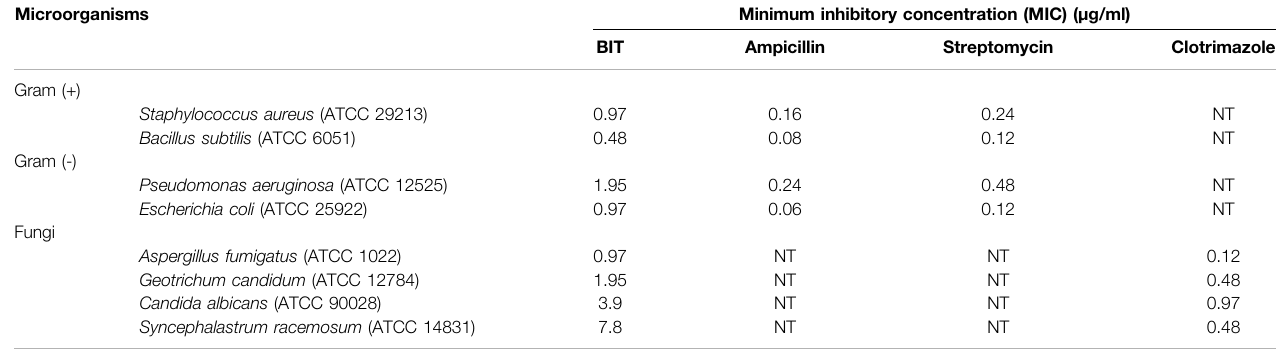
TABLE 2 | Minimum inhibitory concentrations (MICs) of BIT against different pathogens determined by the agar plate method. Microorganisms